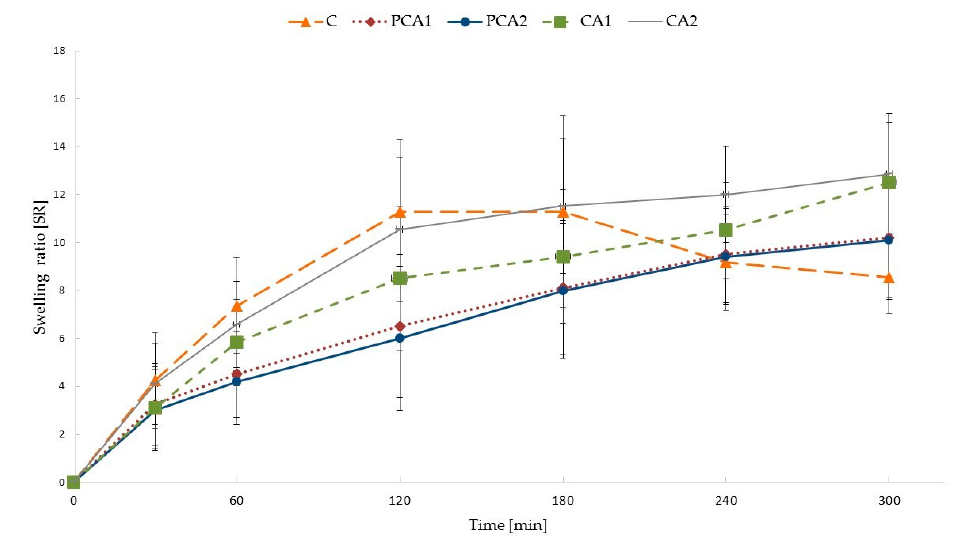
Figure 3. Swelling characteristics of non-modified C and cross-linked formulations PCA1, PCA2, CA1, and CA2.